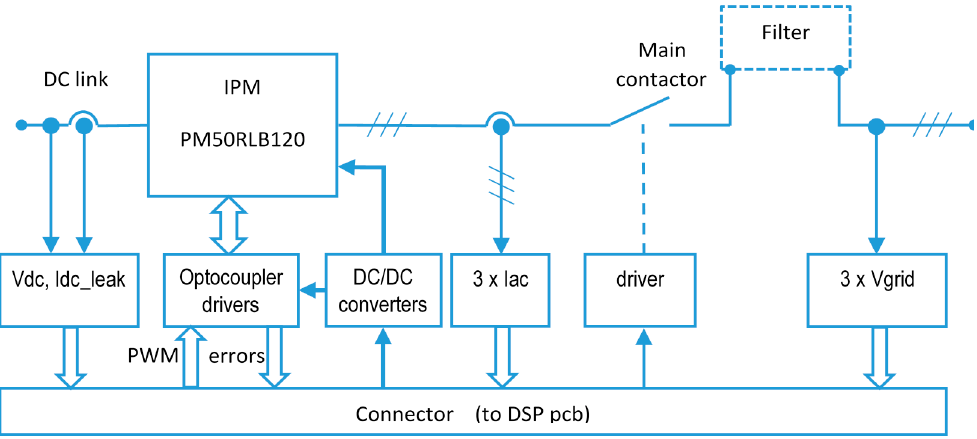
Figure 3. Simplified bloc-schematic of the power board.